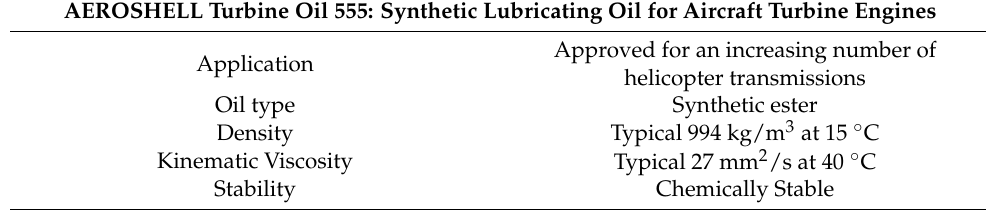
Table 1. Specifications of Aero shell 555, lubricant used in experimental